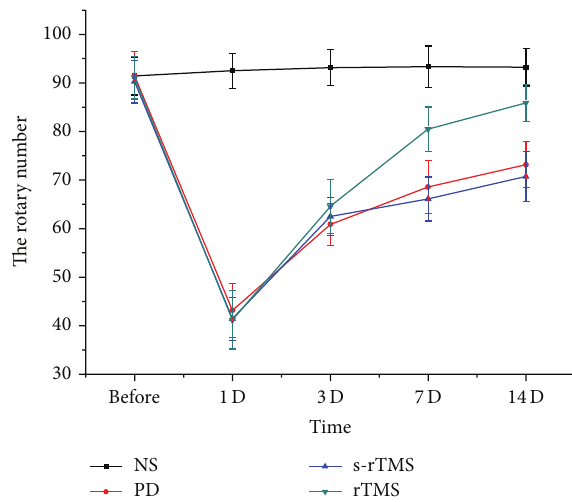
Figure 1: The comparison of rotarod testing in different groups at different time